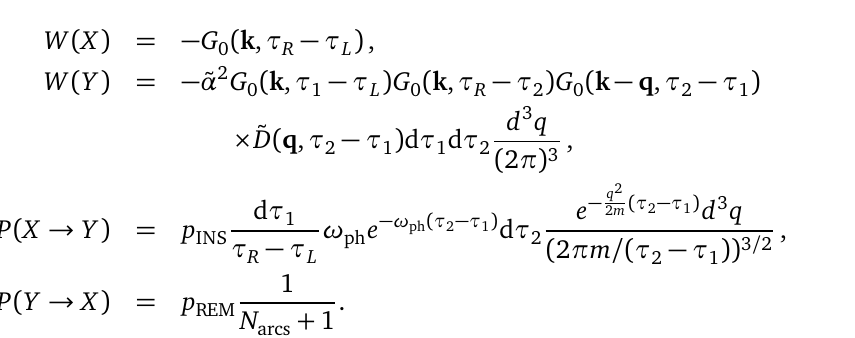
1 and τ , A B and τ . After the update, the 1 2 − q 1 2